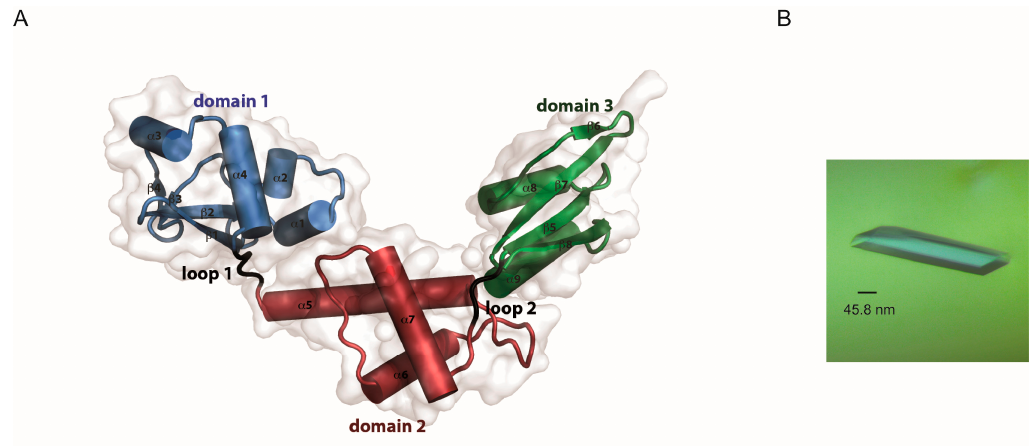
Figure 2. Refined model of the AfSBDS ( A ) and the diffracting crystal ( B ).